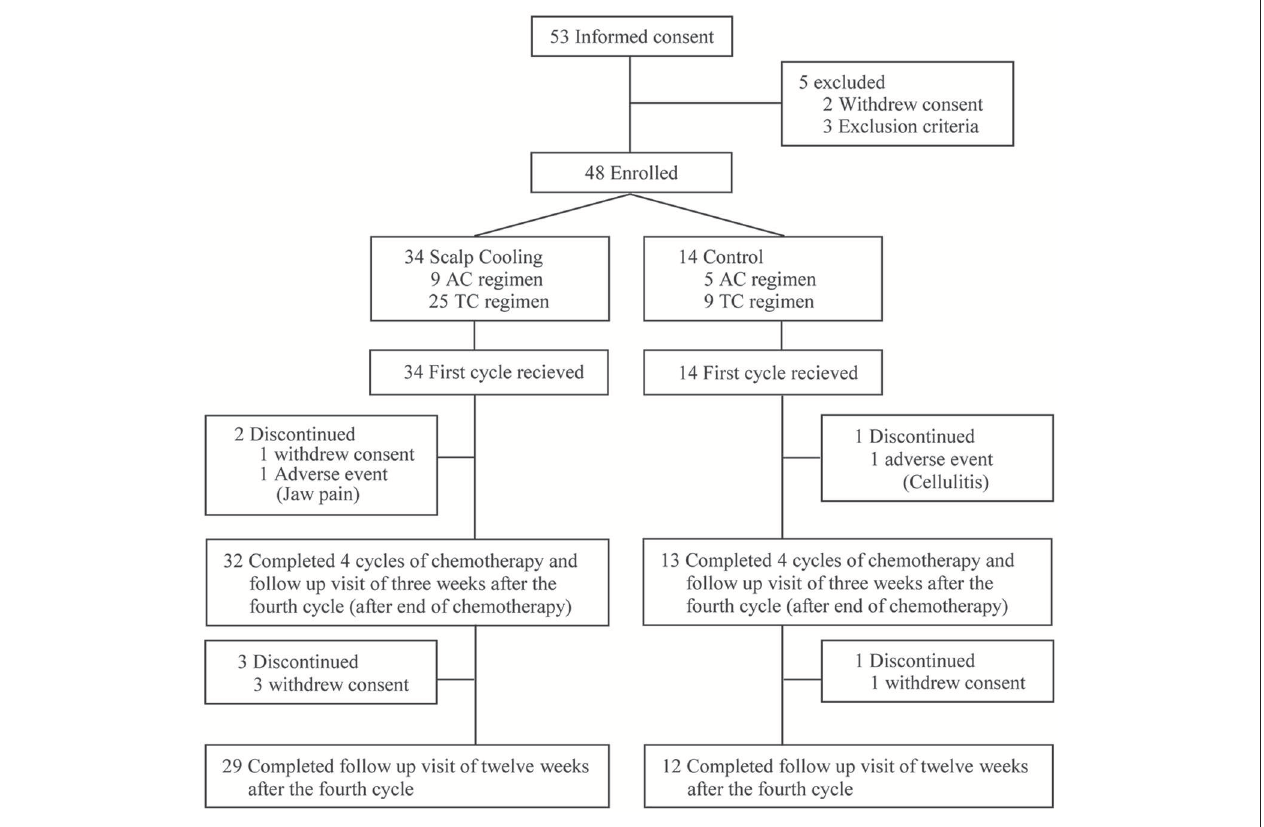
FIGURE 1 | Patient inclusion